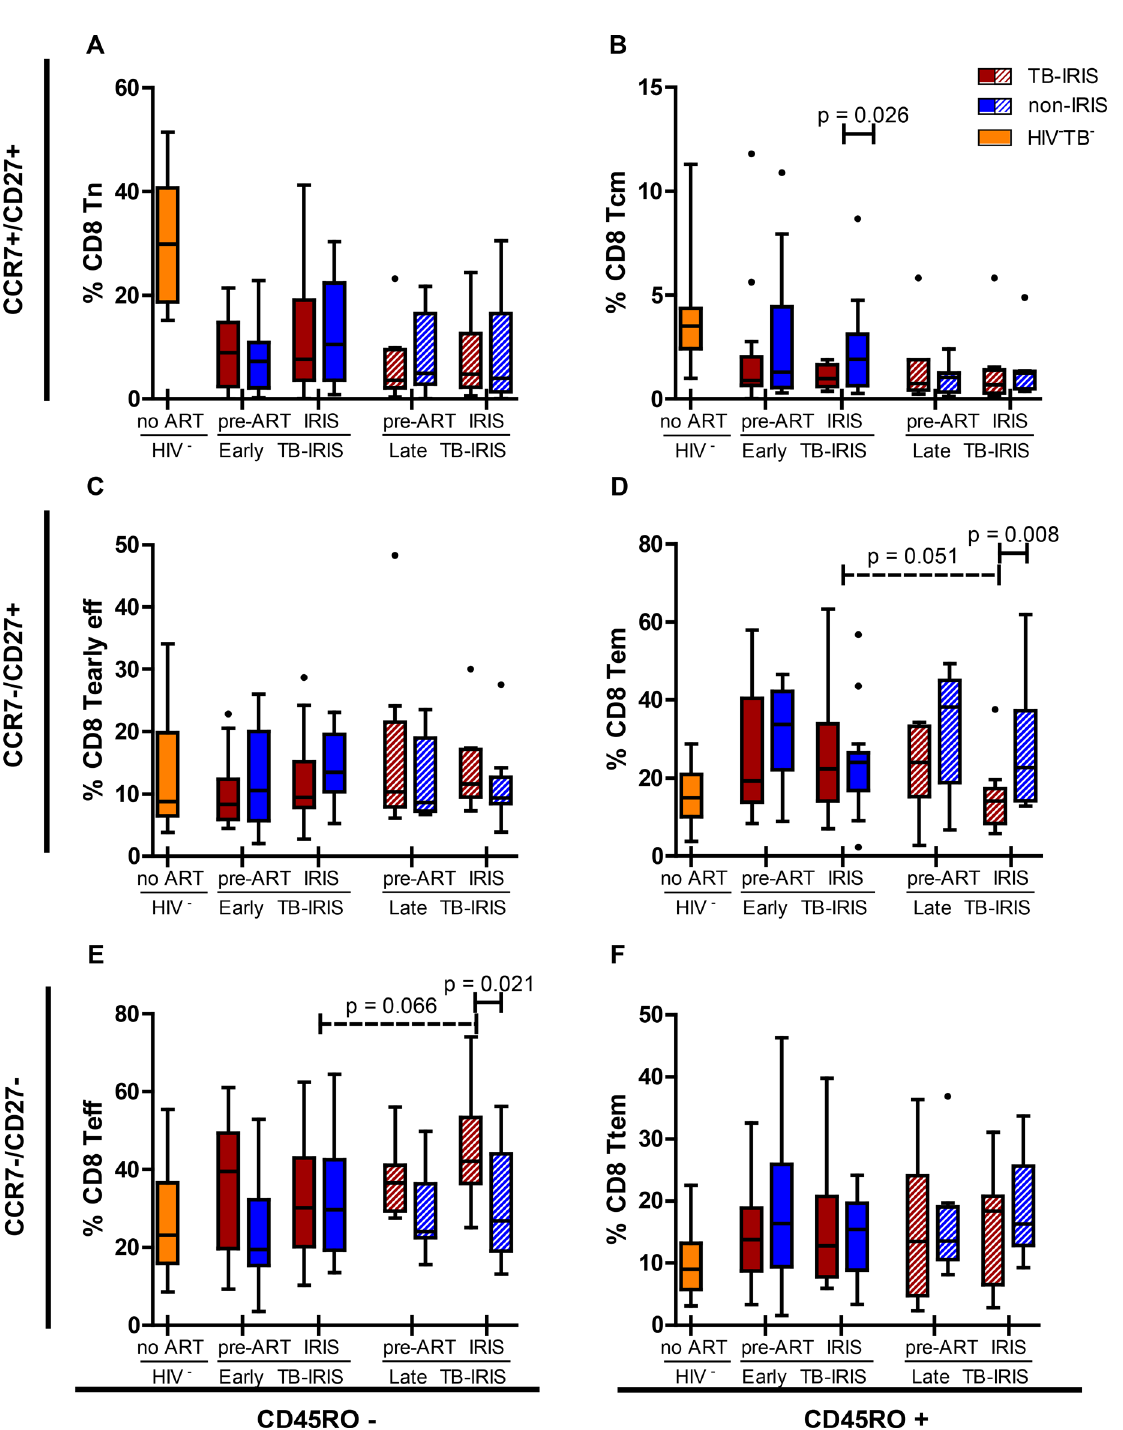
Fig 4. Percentage of CD8+ maturation sub-stages in early-onset TB-IRIS patients. These box and Tukey whisker plots represent median percentages and IQR of; A, na ï ve cells (Tn); B, central memory cells (Tcm); C, early effector cells (Tearly eff); D effector memory cells (Tem); E, effector cells (Teff); F, terminal effector memory cells (Ttem) within CD8+ T cells for early- and late-onset TB-IRIS patients (red) and non-IRIS controls (blue), 16 HIV-TB- (yellow) controls. Full lines above indicate significant differences between paired patients (Wilcoxon signed-rank test). Dashed lines above indicate significant differences between unpaired patient groups (Mann-Whitney U test). The level of significance was set to P < 0.05 for all tests. Number of patients (and paired non-IRIS controls) prior to ART were; 17 for early-onset TB-IRIS and 8 for late-onset TB-IRIS. Number of patients (and paired non-IRIS controls) during IRIS event or corresponding non-IRIS control time point were; 16 for early-onset TB-IRIS and 9 for late-onset TB-IRIS.